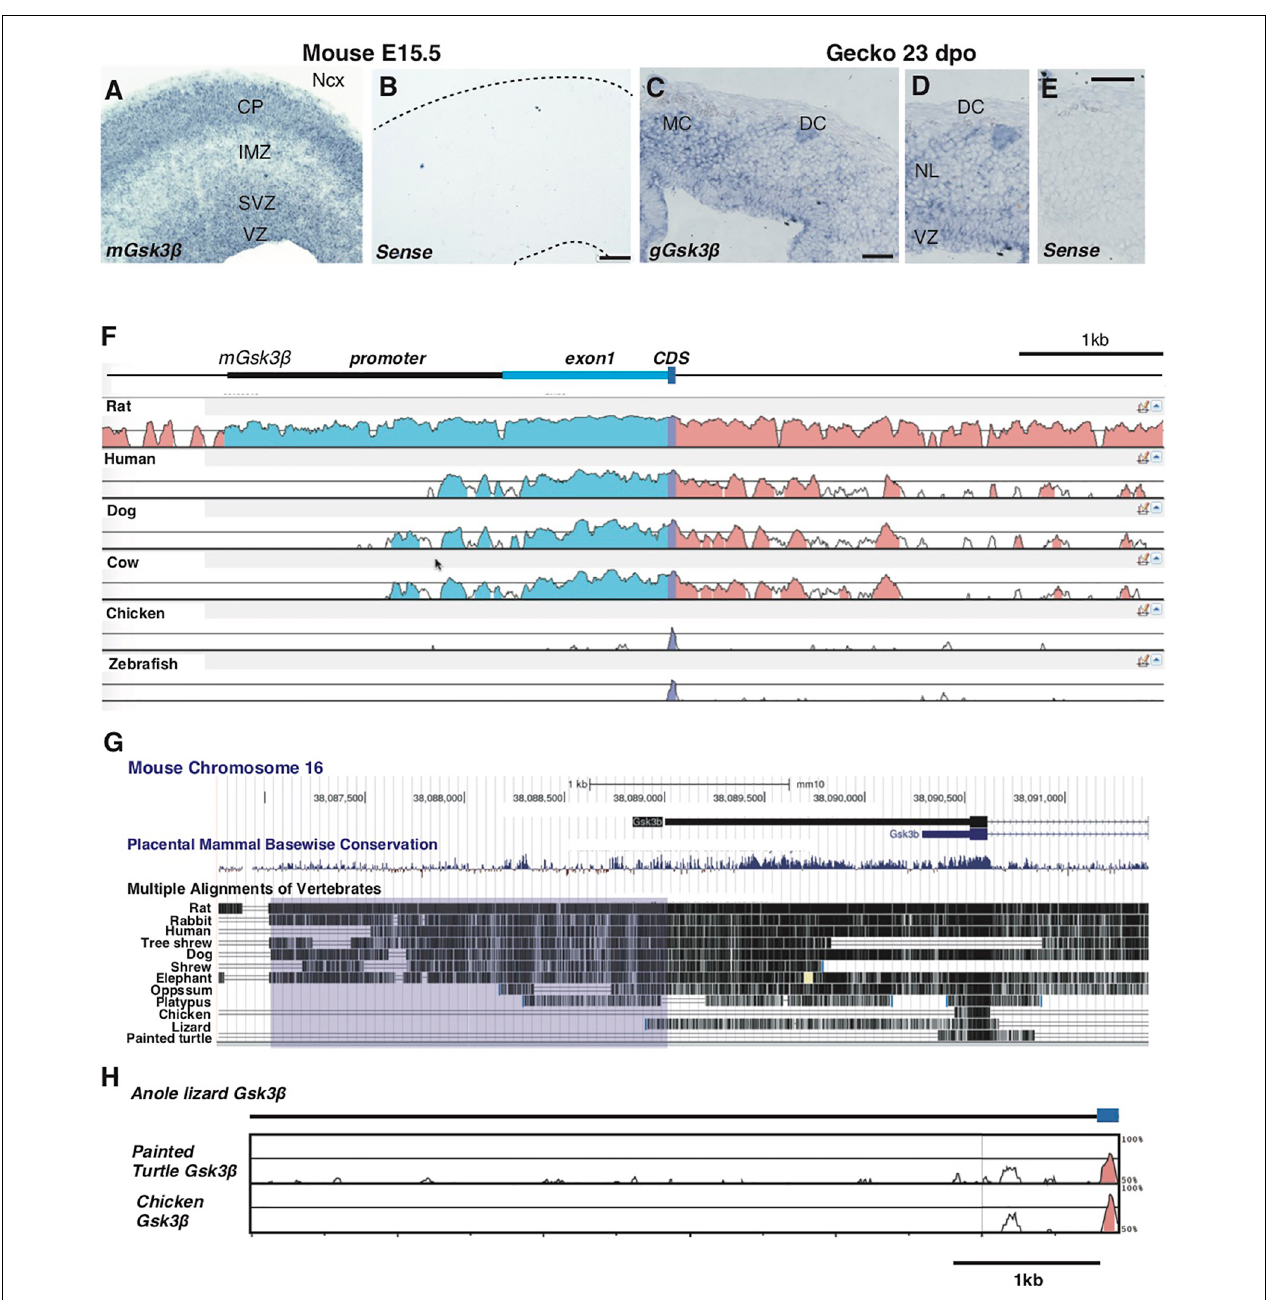
FIGURE 2 | Species-specific genomic structures of Gsk3 β in amniotes. (A–E) Expression patterns of Gsk3 β in E15.5 mouse neocortex (A,B) and 23 dpo gecko dorsal cortex (C–E) . Conservation analyses of Gsk3 β genomic loci among representative vertebrate species [ (F) ; mVISTA] and 12 amniote species [ (G) ; UCSC conservation track]. Peaks in (F) and vertical lines in (G) represent conserved genomic regions in comparison of mouse genomic sequences (mm10). The purple box in (G) represents the region corresponding to the 2 kb promoter of mouse Gsk3 β . (H) Conservation analyses of Gsk3 β genomic loci among non-mammalian species. Peaks represent conserved genomic regions in comparison of anole lizard genomic sequences (Ano Car2.0.v2). CP: cortical plate; IMZ: intermediate zone; SVZ: subventricular zone; VZ: ventricular zone; MC: medial cortex; DC: dorsal cortex; NL: neuronal layer. Scale bars: 100 µ m (B) , 50 µ m (C,E)